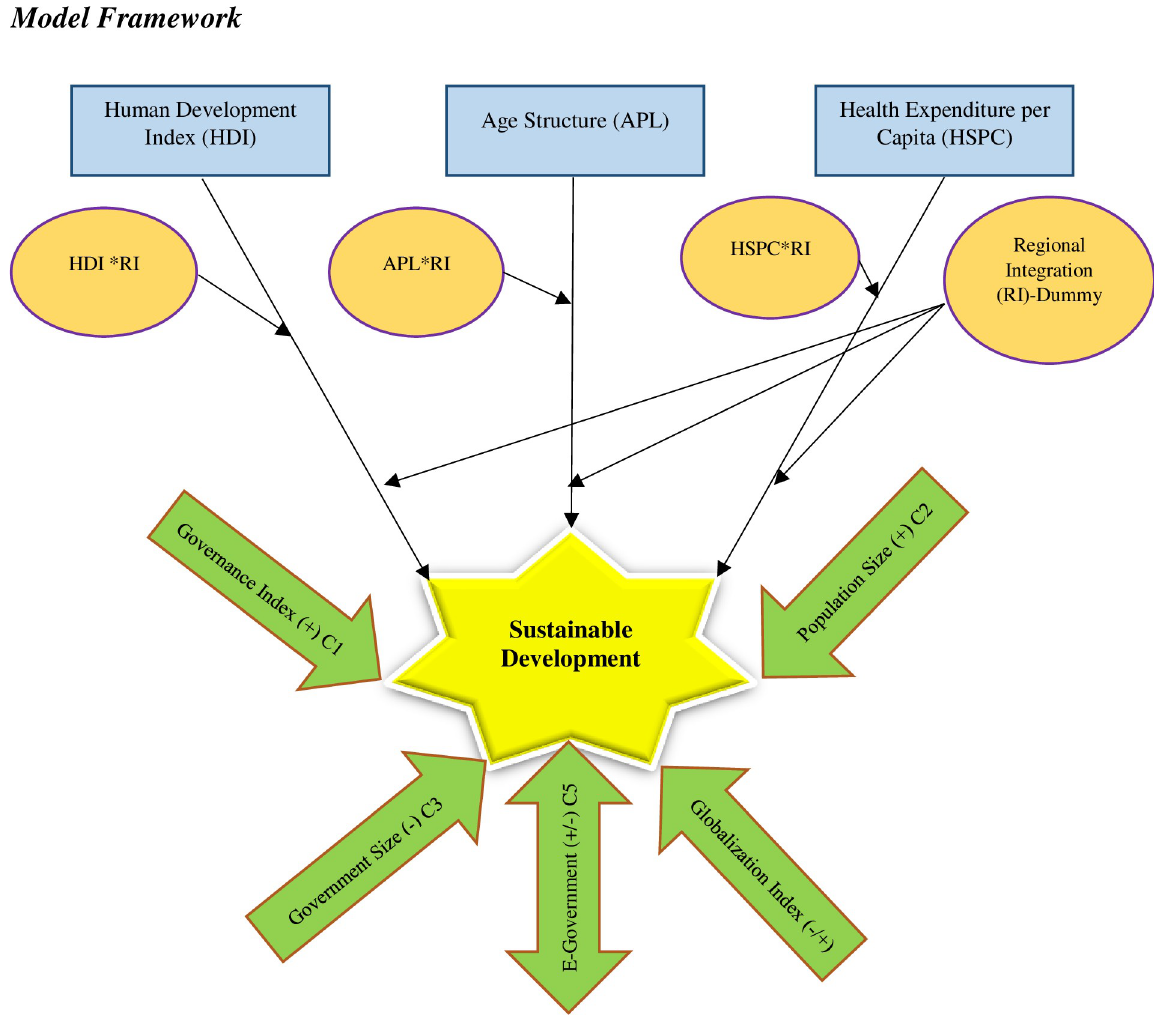
Fig 1. Conceptual